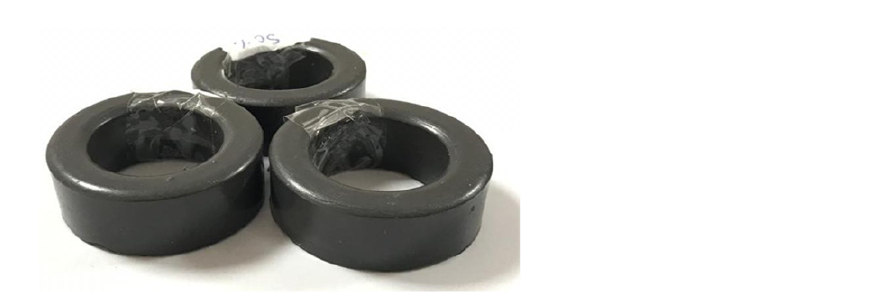
Figure 4. Toroidal magnetic cores elaborated with the composite material after machining. 3. Determination of the Permeability of the Magnetic Cores with the